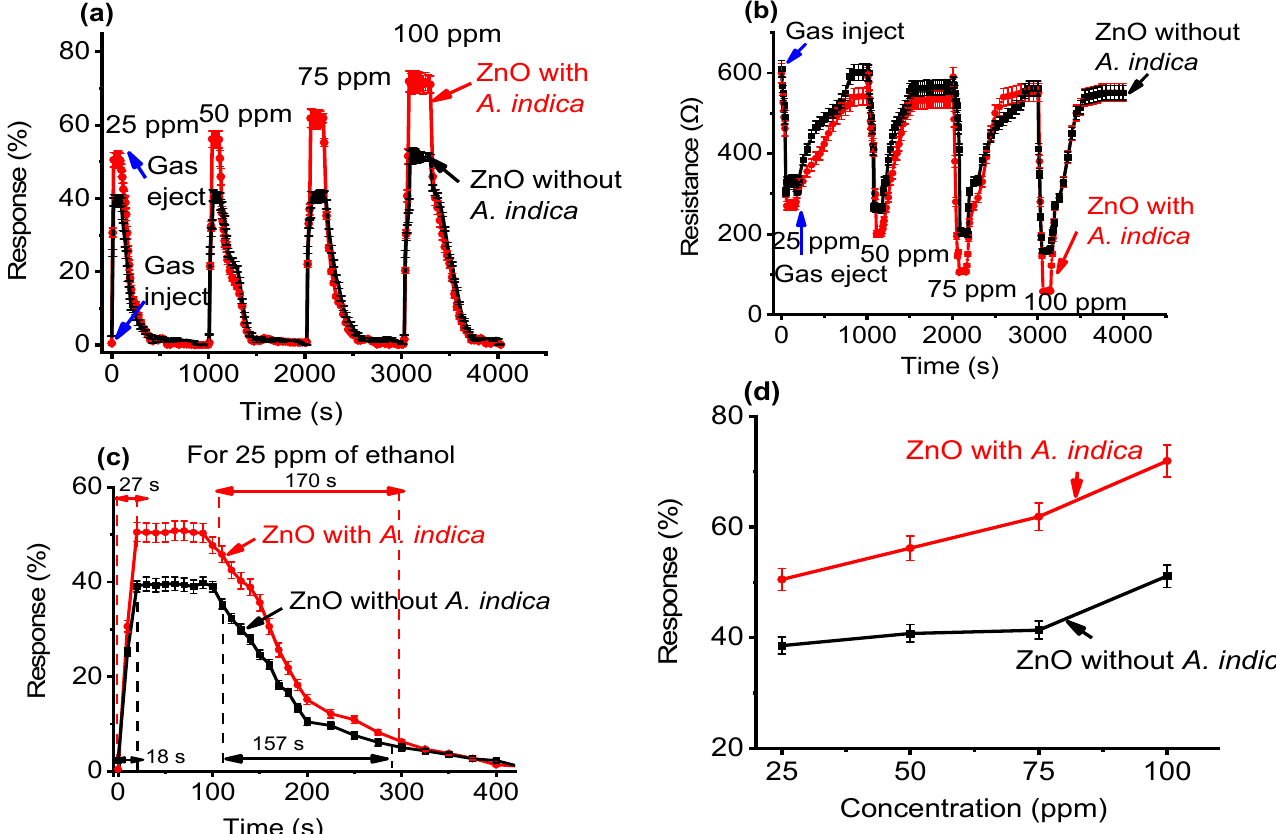
Figure 6. ( a ) Sensitivity measurement of ZnO thin films as a function of time. ( b ) Response curve with time scale and sensor resistance for 25, 50, 75, and 100 ppm ethanol at operating temperature. ( c ) Calculation of the response and recovery time of ZnO thin film for 25 ppm ethanol. ( d ) Sensitivity measurement of ZnO thin films as a function of